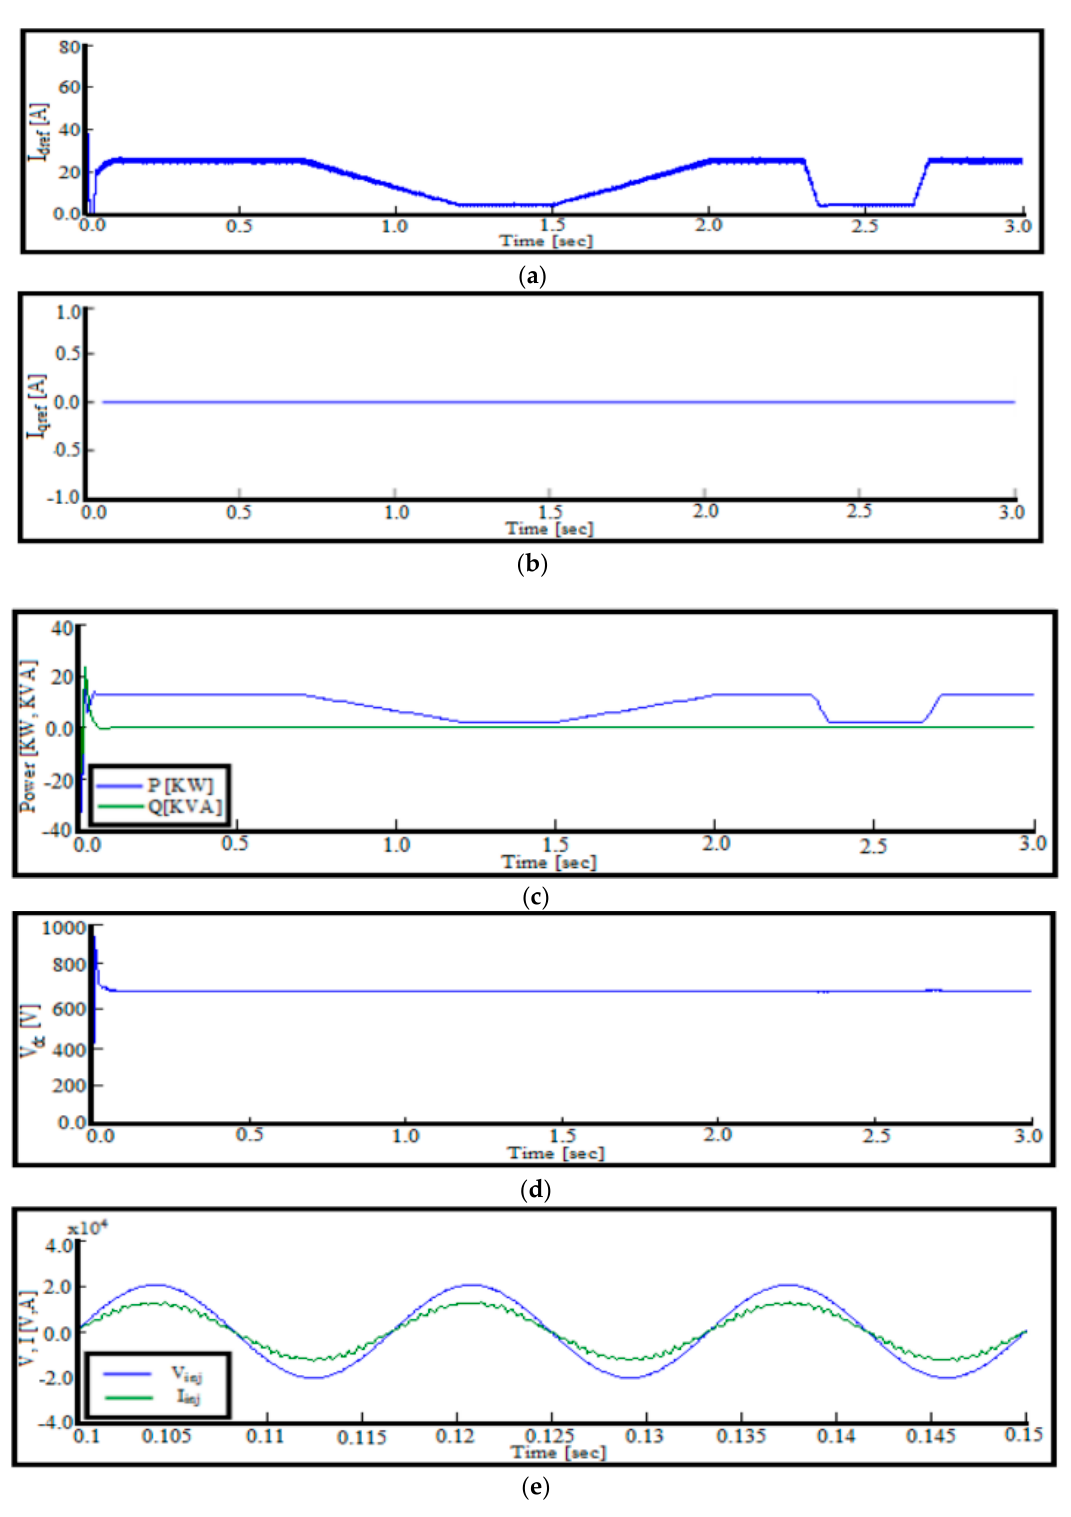
Figure 26. ( a ) I dreq vs. Time of P&O at Grid Side; ( b ) I qref vs. Time of P&O at Grid Side; ( c ) Power in KW and KVA vs. Time of P&O at Grid Side; ( d ) V dc vs. Time of P&O at Grid Side; ( e ) Current and voltage injected to the grid of P&O at Grid Side.